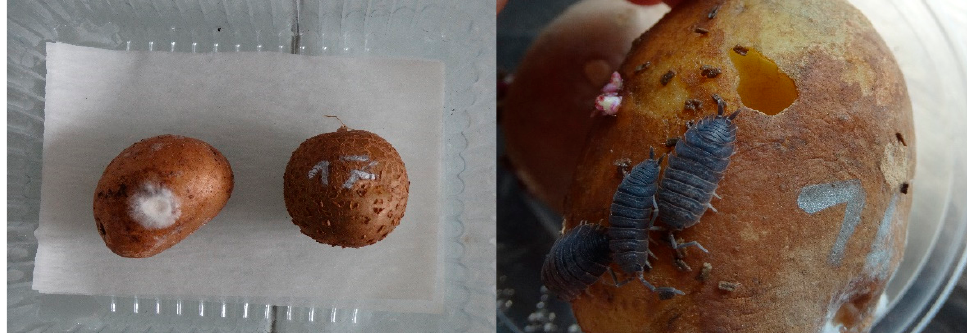
Figure 6. Experimental setup with small boxes: the effect of Porcellionides pruinosus on Fusarium solani infection of stored potato (Gödöll ő , Hungary, 2017). Agriculture 2022 , 12 , x FOR PEER REVIEW